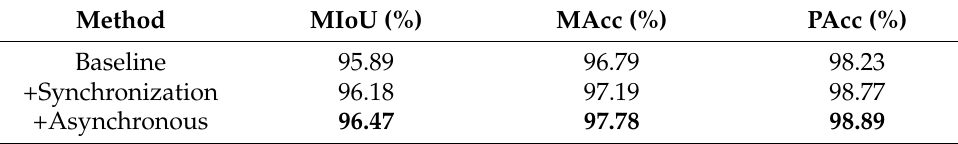
Table 2. Asynchronous position coding ablation experiment